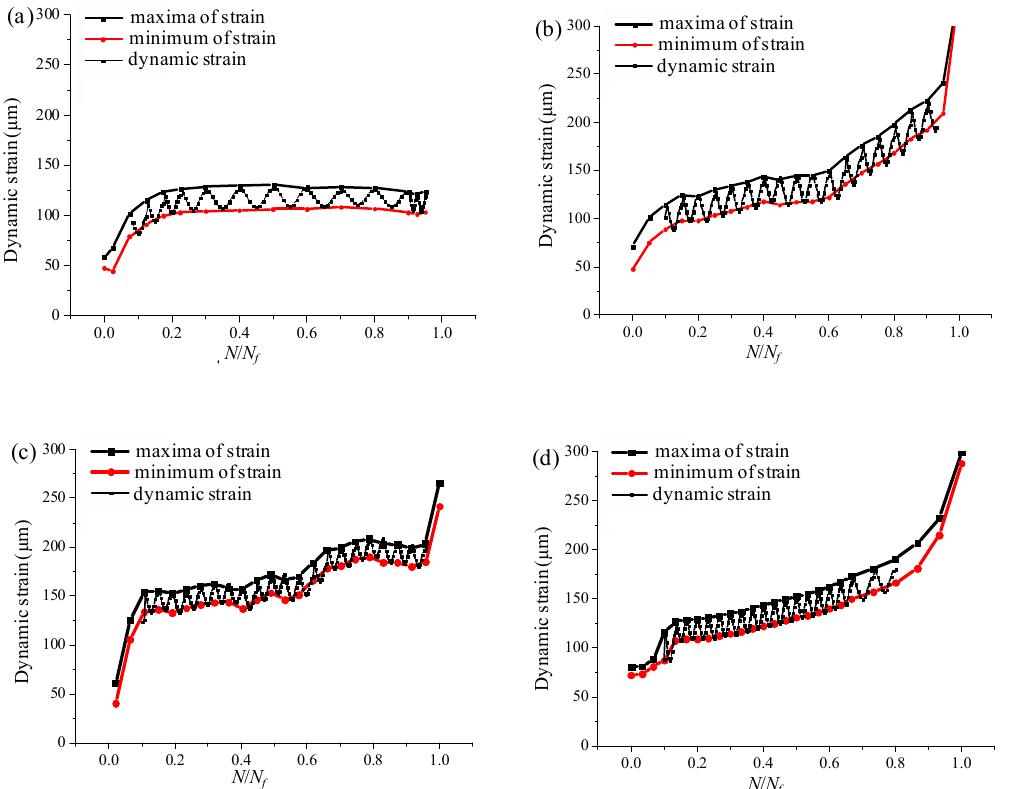
Figure 12. Dynamic strain curve: ( a ) static load = 25 kN, ( b ) static load = 27 kN, ( c ) static load = 29 kN, and ( d ) static load = 31 kN.